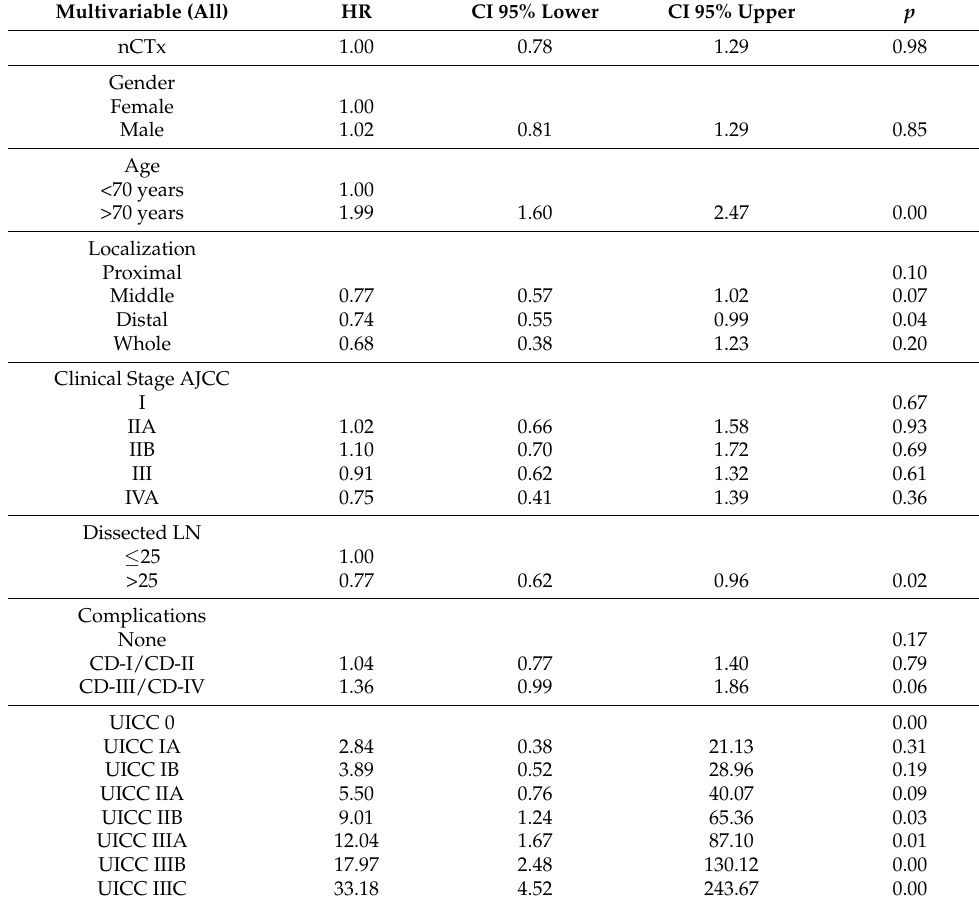
Table 3. Multivariable analysis (all